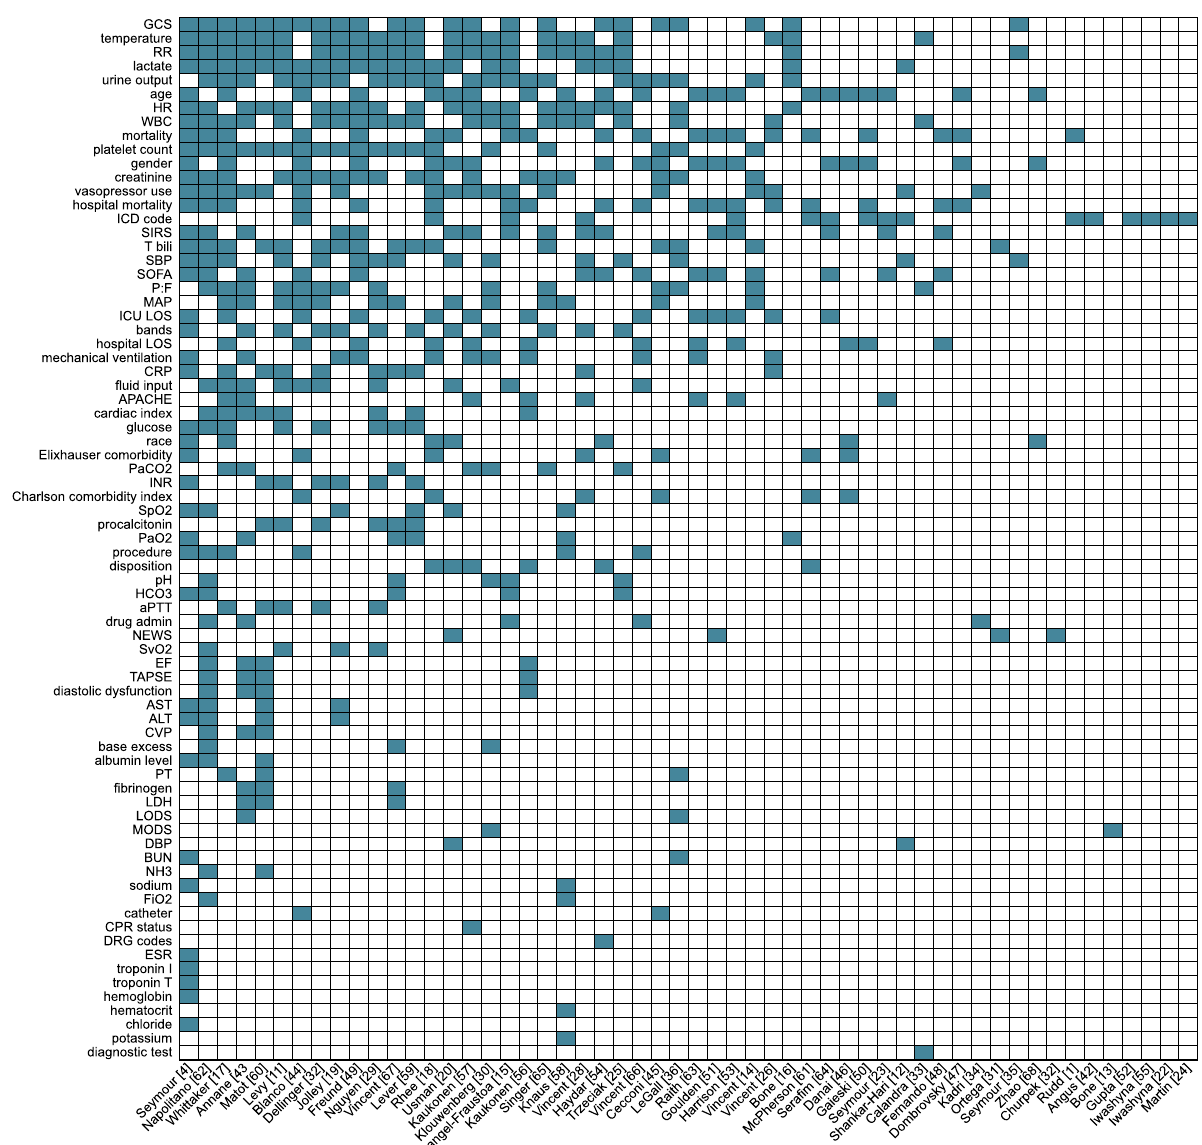
Fig. 3 Data elements reported by a manuscript in heatmap. Data elements are displayed on the y axis; manuscripts included in analysis displayed on x axis. Axes are sorted so variables most frequently cited are grouped together on the left, whereas manuscripts contributing infrequently reported variables are grouped on the right. Blue shading represents the data element reported by the manuscript, whereas data elements not reported by the manuscript are not shaded. RR respiratory rate, GCS Glasgow Coma Scale score, WBC white blood cell count, HR heart rate, T Bili, total bilirubin, SIRS systemic in fl ammatory response syndrome, SBP systolic blood pressure, P:F ratio of partial pressure of arterial oxygen to fraction of inspired oxygen, ICD international classi fi cation of diseases, SOFA sequential organ failure assessment score, ICU intensive care unit, LOS length of stay, MAP mean arterial pressure, CRP c-reactive protein, APACHE acute physiology and chronic health enquiry, INR international normalized ratio, PaCO 2 partial pressure of arterial carbon dioxide, SpO 2 oxygen saturation, aPTT activated partial thromboplastin time, HCO 3 bicarbonate, ALT alanine aminotransferase, AST aspartate aminotransferase, TAPSE tricuspid annular plane systolic excursion, EF ejection fraction, SvO 2 saturation of venous oxygen, NEWS national early warning system, LDH lactate dehydrogenase, PT prothrombin time, CVP central venous pressure, FiO 2 fraction of inspired oxygen, NH 3 ammonia level, BUN blood urea nitrogen, DBP diastolic blood pressure, MODS multiple organ dysfunction syndrome, LODS logistic organ dysfunction syndrome, ESR erythrocyte sedimentation rate, DRG diagnosis-related data and codes for laboratory and clinical observations. FHIR To promote fl exibility, we linked variables to several FHIR mappings frequently link to more than one LOINC code. For resource types whenever possible. For example, the variable “ serum sodium ” is represented as a FHIR Observation resource example, blood urea nitrogen (BUN) mapped to both LOINC codes 3094-0 (BUN SerPl-mCnc) and 6299-2 (BUN Bld-mCnc). For where the Observation.code data element is mapped to the variables linked to more than one code, we established a HL7 Logical Observation Identi fi ers Names and Codes (LOINC) code FHIR-based sepsis value set to represent a set of codes with the 2951-2 (referring to “ Sodium [Moles/volume] in Serum or Plasma ” ). same clinical meaning. Most variables (99 out of 151) were FHIR LOINC is the most commonly used international healthcare resource observations with direct mappings to LOINC codes. terminology standard which describes a reference set of health